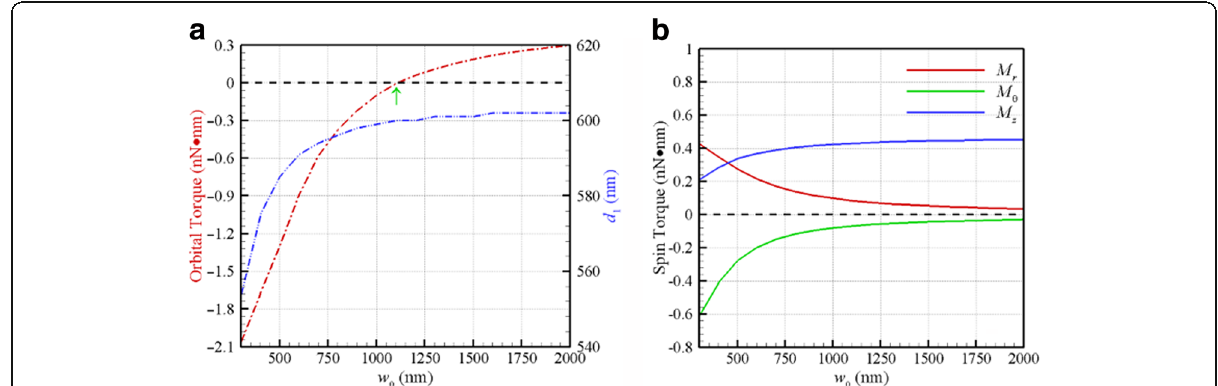
Fig. 4 a The optical orbital torque and d 1 at the first stable-equilibrium orbit versus the waist of a Gaussian beam of λ = 800 nm. The turning point of the waist for producing positive or negative orbital torque is at 1150 nm. b The optical spin torques versus the waist at d 1